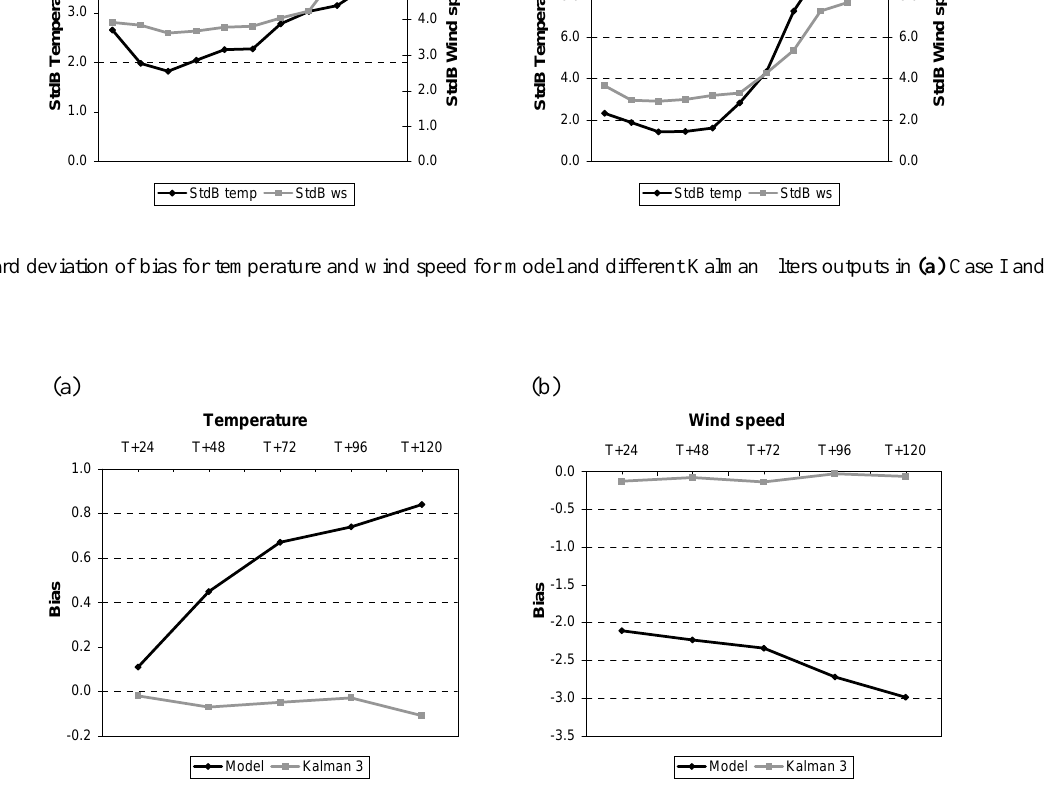
Fig. 7. Variation of (a) temperature and (b) wind speed bias with forecast time for the direct model output and after the application of order-3 Kalman filter, for the year 2003